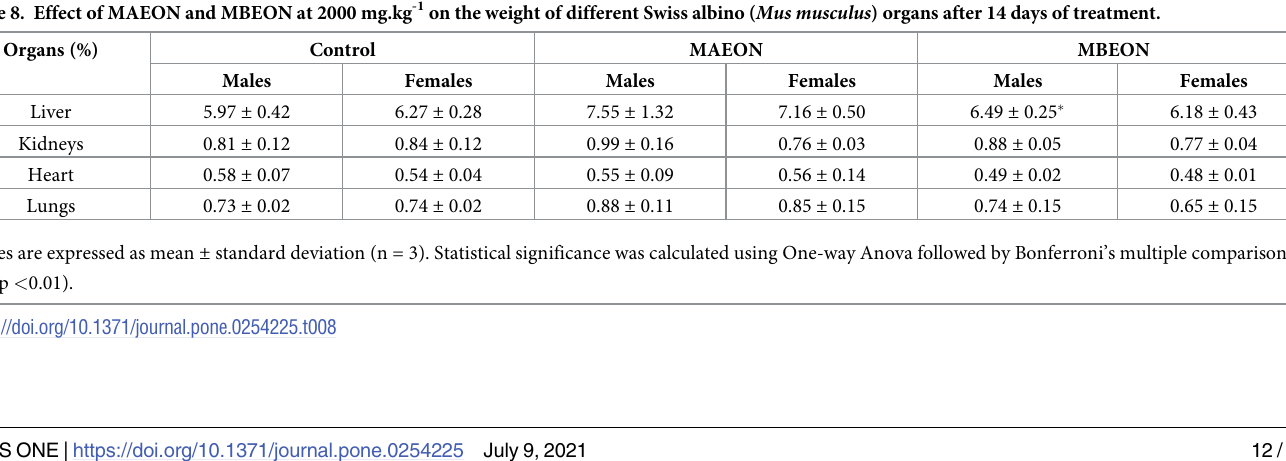
Table 8. Effect of MAEON and MBEON at 2000 mg.kg -1 on the weight of different Swiss albino ( Mus musculus ) organs after 14 days of treatment. Organs (%)